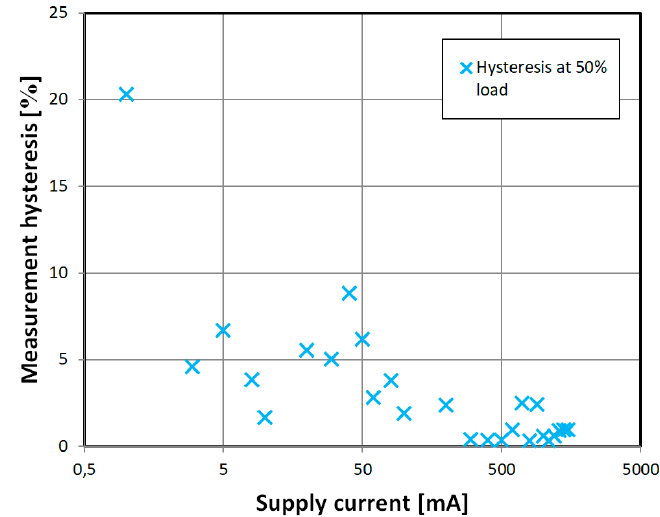
Figure 14. Obtained experimental characteristic of measurement hysteresis vs magnetizing current for the developed ‘diagonal’ sensor. Sinusoidal current of 432 Hz frequency.